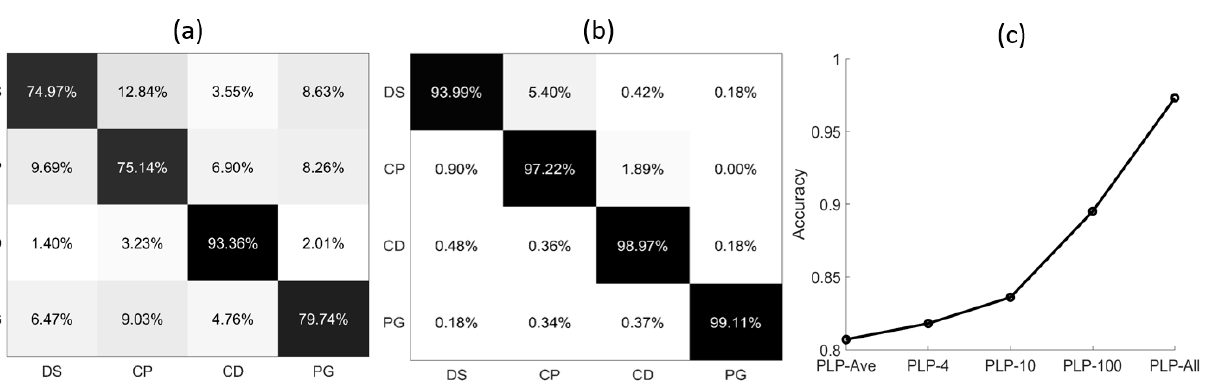
Figure 4. The confusion matrix of different polarized light pulses methods: ( a ) PLP-Ave model; ( b ) PLP-All model; ( c ) average accuracy of five models. Table 1. Accuracy of PLP-Ave model and PLP-All model.